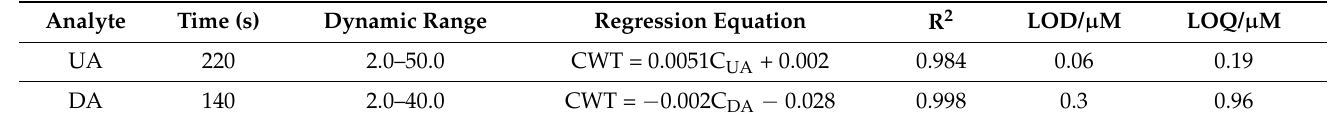
Table 1. Statistical results of calibration graphs obtained at zero-crossing points using CWT-sym8.